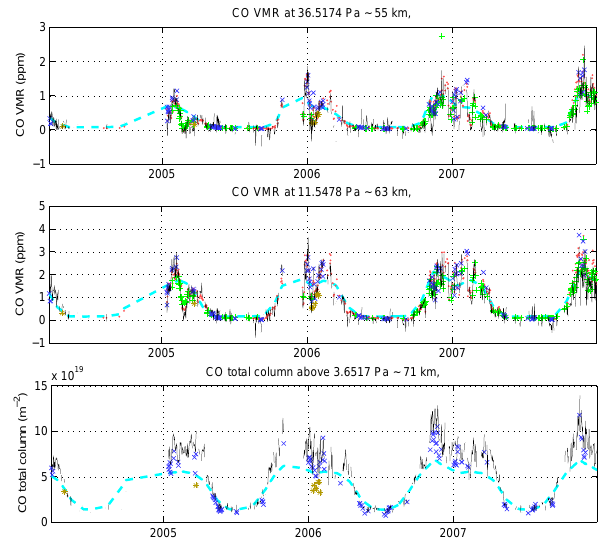
Fig. 9. Time series of CO mixing ratio at 55km and 63km and columns above 71km for the time period 2002–2004 are shown: OSO (black), MIPAS (12+13, green plus), SMR (V021, brown cross; V225, brown stars) and a priori (cyan).